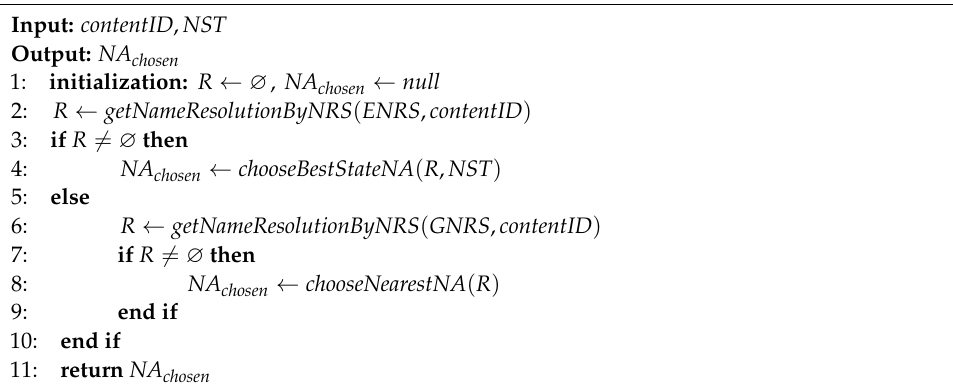
Algorithm 1: The Operation Process of